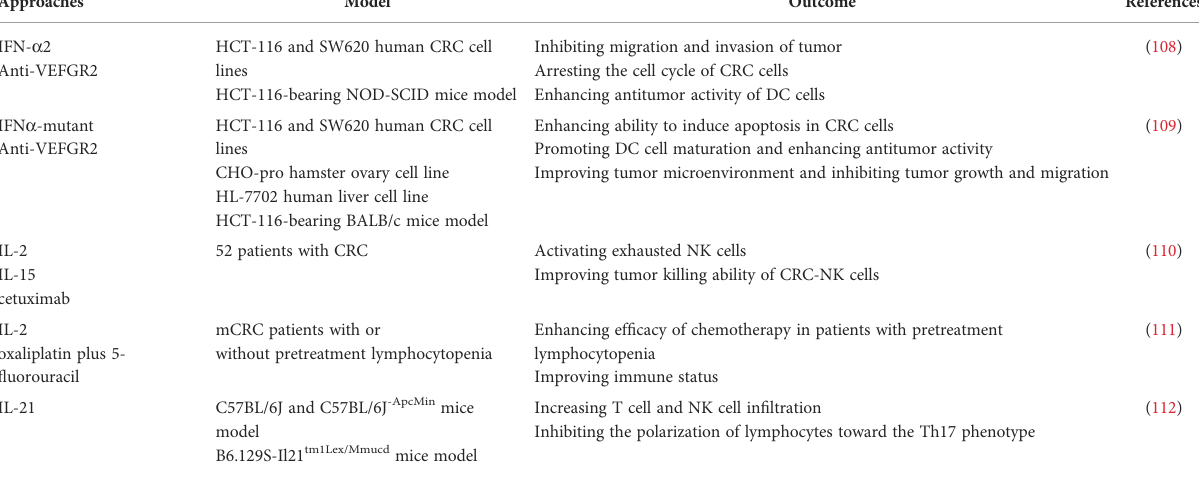
TABLE 3 Different applications of cytokines in colorectal